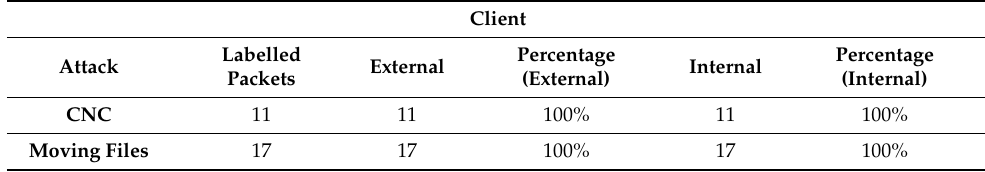
Table 12. Detected attacks towards the